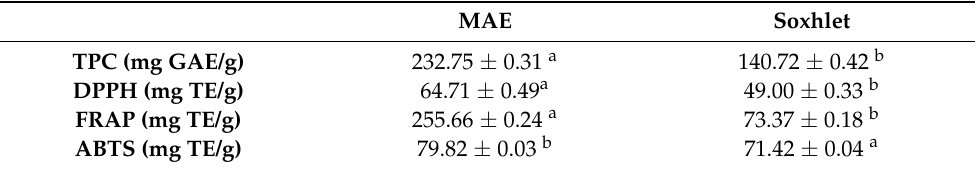
Table 5. Results of total phenolic content (TPC) and antioxidant activity (DPPH, FRAP and ABTS assays) of the Curcuma longa L. oil extraction by MAE (microwave-assisted extraction technique) and Soxhlet. Values were mean ± standard deviation (n = 3). Superscript letters represent significant differences (Duncan’s test, p < 0.05) between each assay with the two extraction